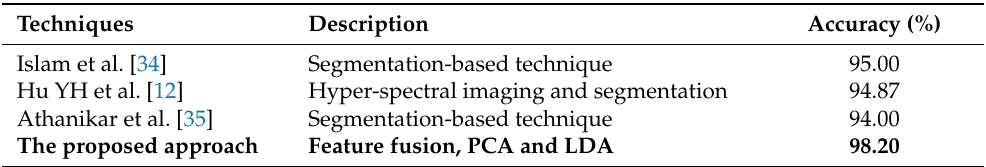
Table 4. Performance comparison of the proposed and existing approaches for Potato leaf disease